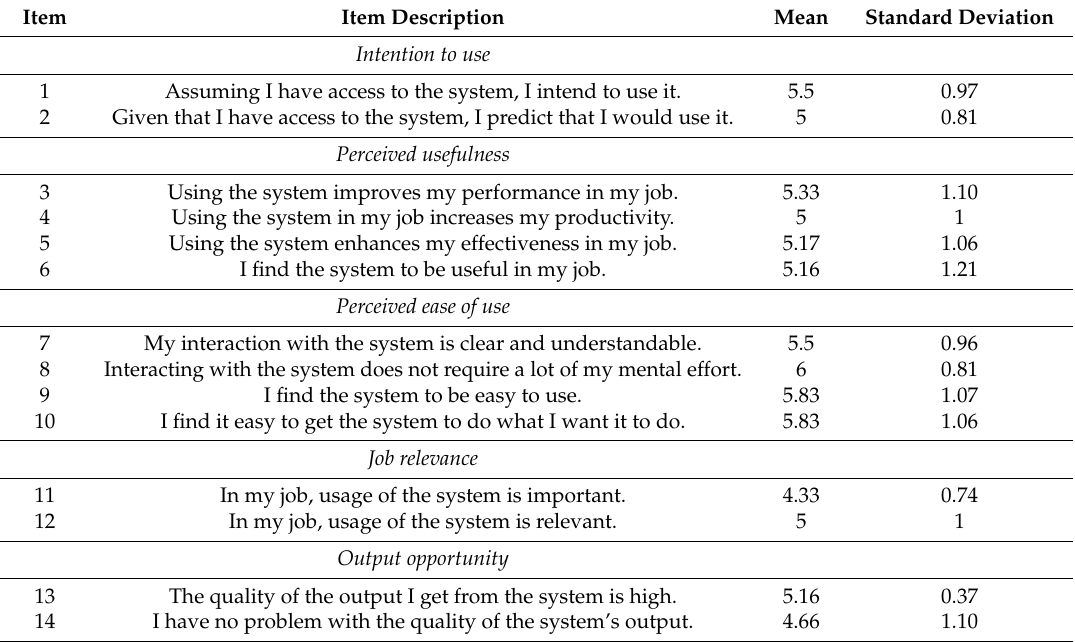
Table 2. The results of the administered Technology Acceptance Model 2 (TAM2) questionnaire.